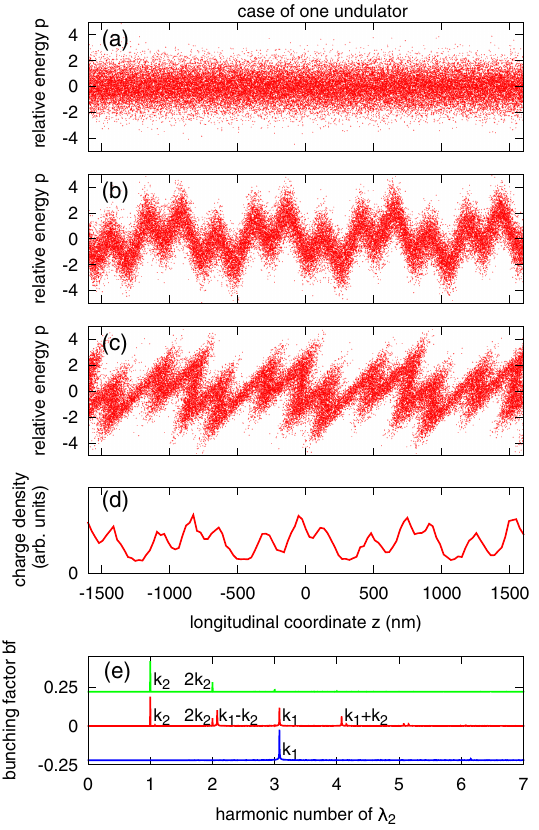
FIG. 2. Electron bunch longitudinal characteristics at each step of the frequency mixing process (case of one undulator). Phase- space of the electron-bunch, (a) initially, (b) after the interaction with the 2 external lasers, and (c) after the dispersive section. Associated (d) charge density ρ ð z; t Þ and (e) bunching factor bf (red line). Blue and green lines: bunching factor obtained with only one laser (blue line: E 2 ¼ 0 , green line: E 1 ¼ 0 . For clarity these bunching factors are shifted by þ 0 . 22 and − 0 . 22 , respec- tively). Parameters: E 0 ¼ 1 . 2 GeV, σ E ¼ 150 keV, N 1 ¼ 30 , λ ¼ 100 mm, λ ¼ 800 nm, λ ¼ 260 nm, λ ¼ 800 nm, w 1 m 1 1 2 E ¼ 1 GV = m, E ¼ 0 . 18 GV = m, w ¼ 500 μ m, w ¼ 870 μ m, 1 2 1 2 R ¼ 4 . 554 × 10 − 4 m, N ¼ 2 × 10 6 . The bunching factors 56 mp are calculated over 200 periods of λ m 1 and each period is ¼ 30 discretized in N bin